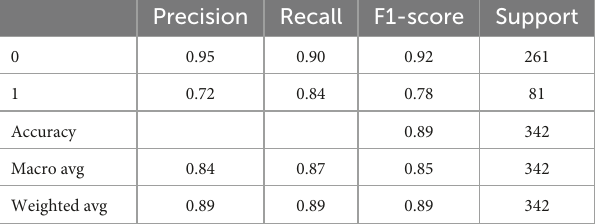
TABLE 5 LR model quality before optimization.